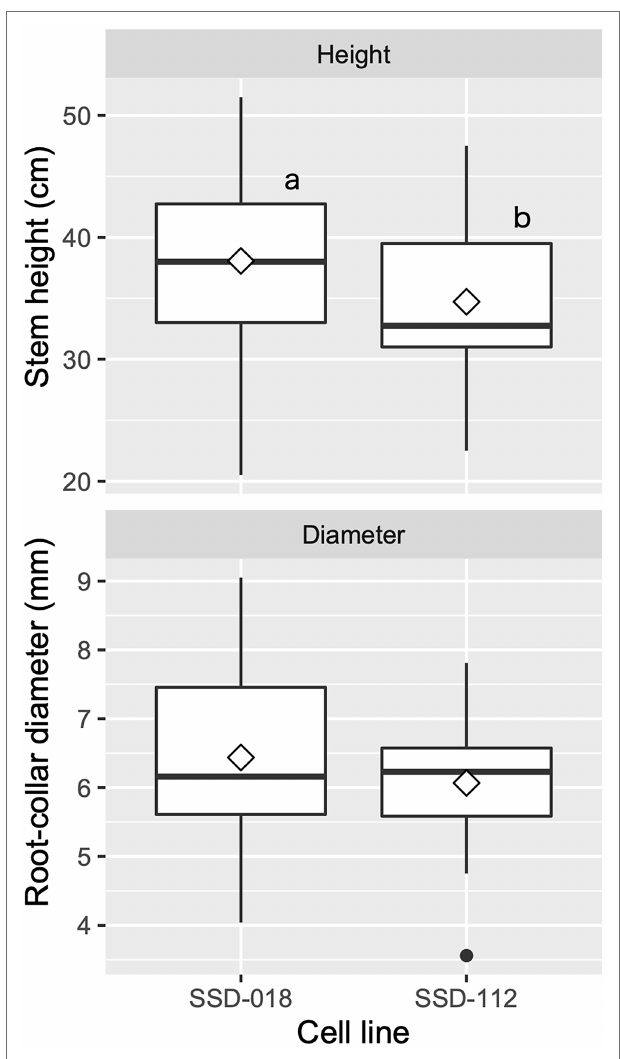
FIGURE 9 | Growth of containerized somatic seedlings of pollen-free sugi ( C. japonica ) in Niigata Prefecture (central region of Japan) before being planted in the field. The open diamond and the dot represent the mean and outlier, respectively. The different letters indicate significant differences among the cell lines ( p < 0.05, pairwise comparison with BH